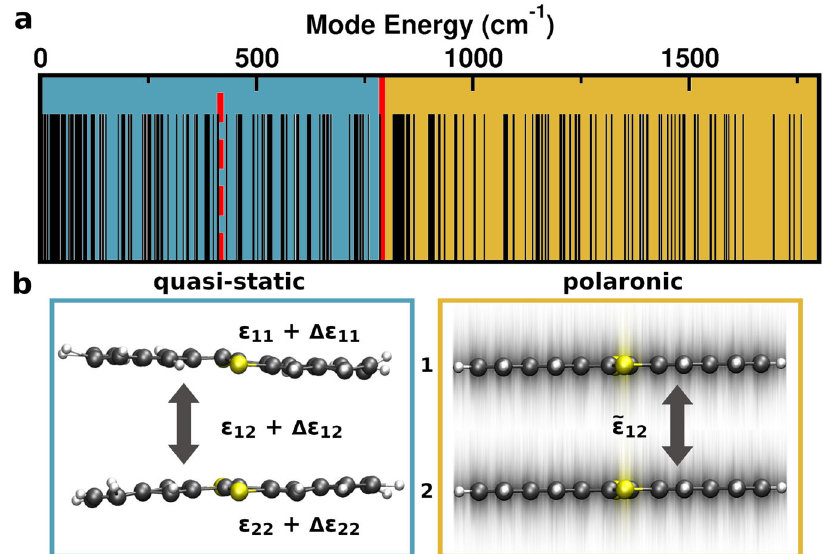
Fig. 1 Separation of quasi-static and polaronic vibration modes. a Mode spectrum of a DNTT crystal. The separating energy (the maximum ) is highlighted as red vertical bar. Modes with lower energy are treated in the quasi-static limit (blue), modes with larger transfer integral ε max MN energy in the polaronic limit (orange). As a reference, twice the thermal energy 2 k B T at room temperature is highlighted as dashed red bar. b The quasi-static treatment generates static disorder in the transfer integrals ε MN and onsite energies ε MN . The polaronic treatment generates a narrowing of the electronic transfer integrals ε MN